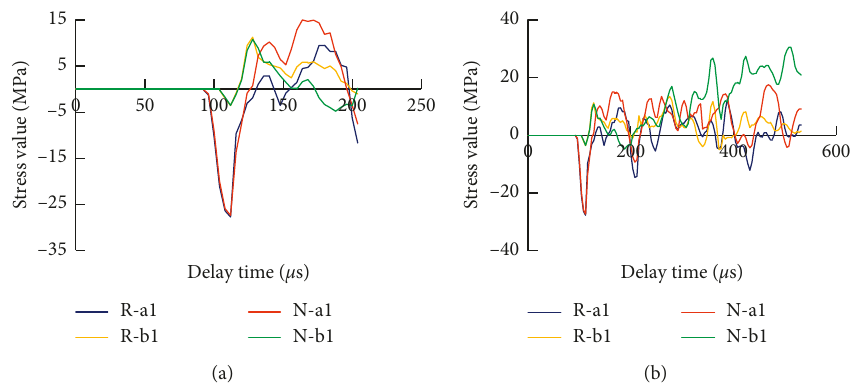
Figure 13: Stress concentration curve of elements a1 and b1 of TBH wall before TBH initiation for different PBH shapes. (a) Delay time 194 μ s. (b) Delay time 536 μ